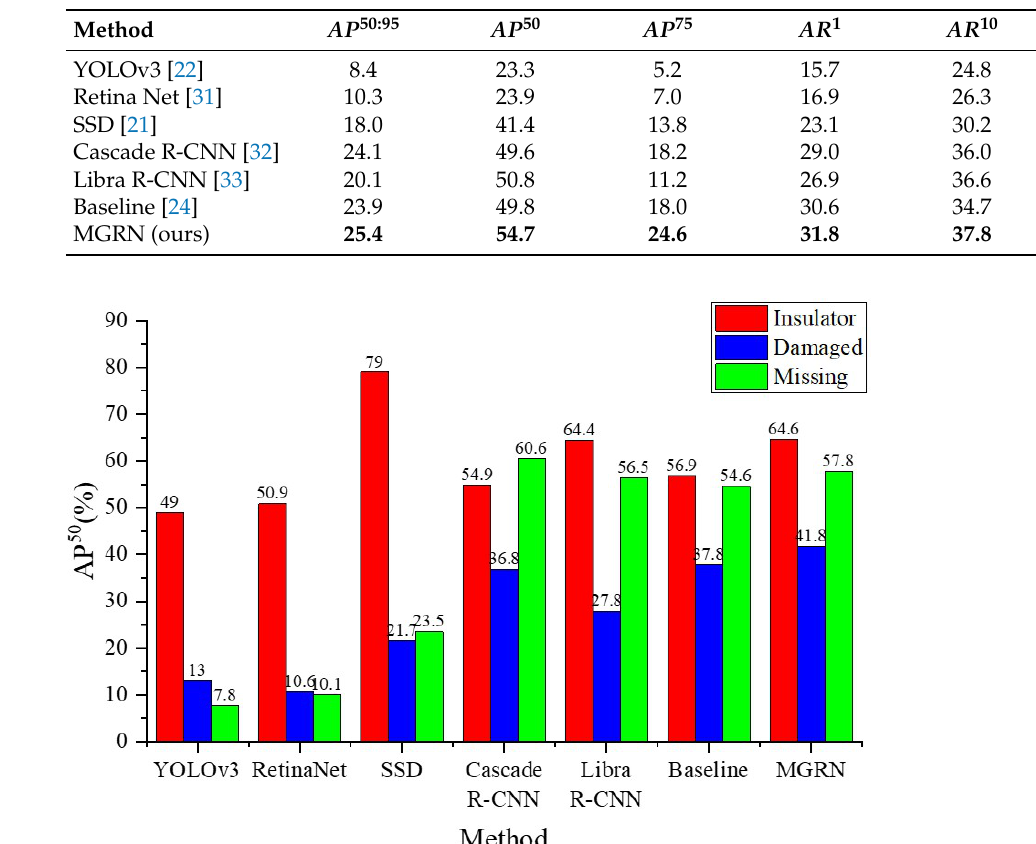
Table 2. Performance comparison of different detection methods. Bolded numbers indicate optimal.